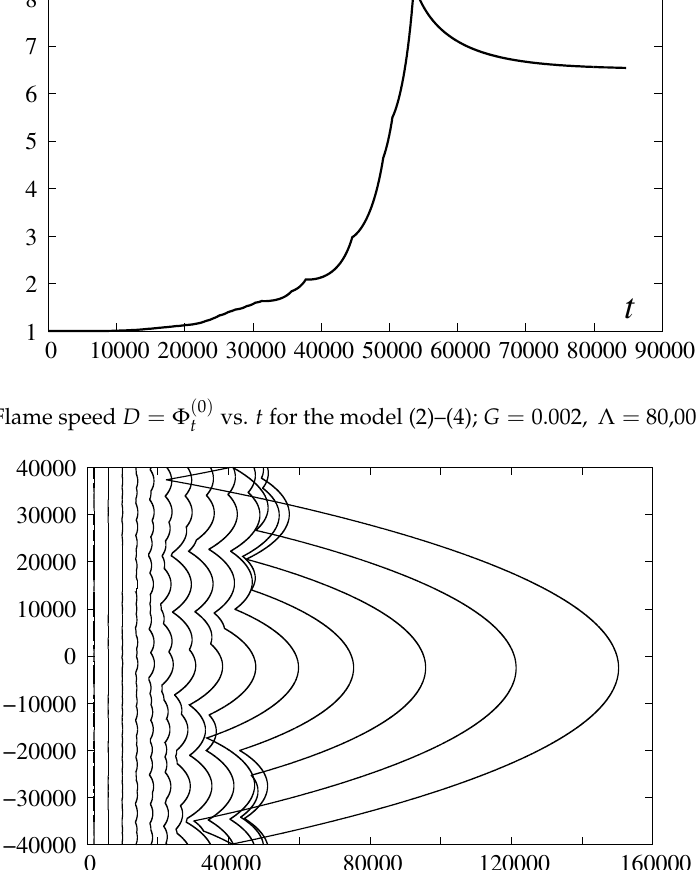
Figure 9. Flame front configurations for the model (2)–(4); G = 0.002, Λ = 80,000, N = 2 15